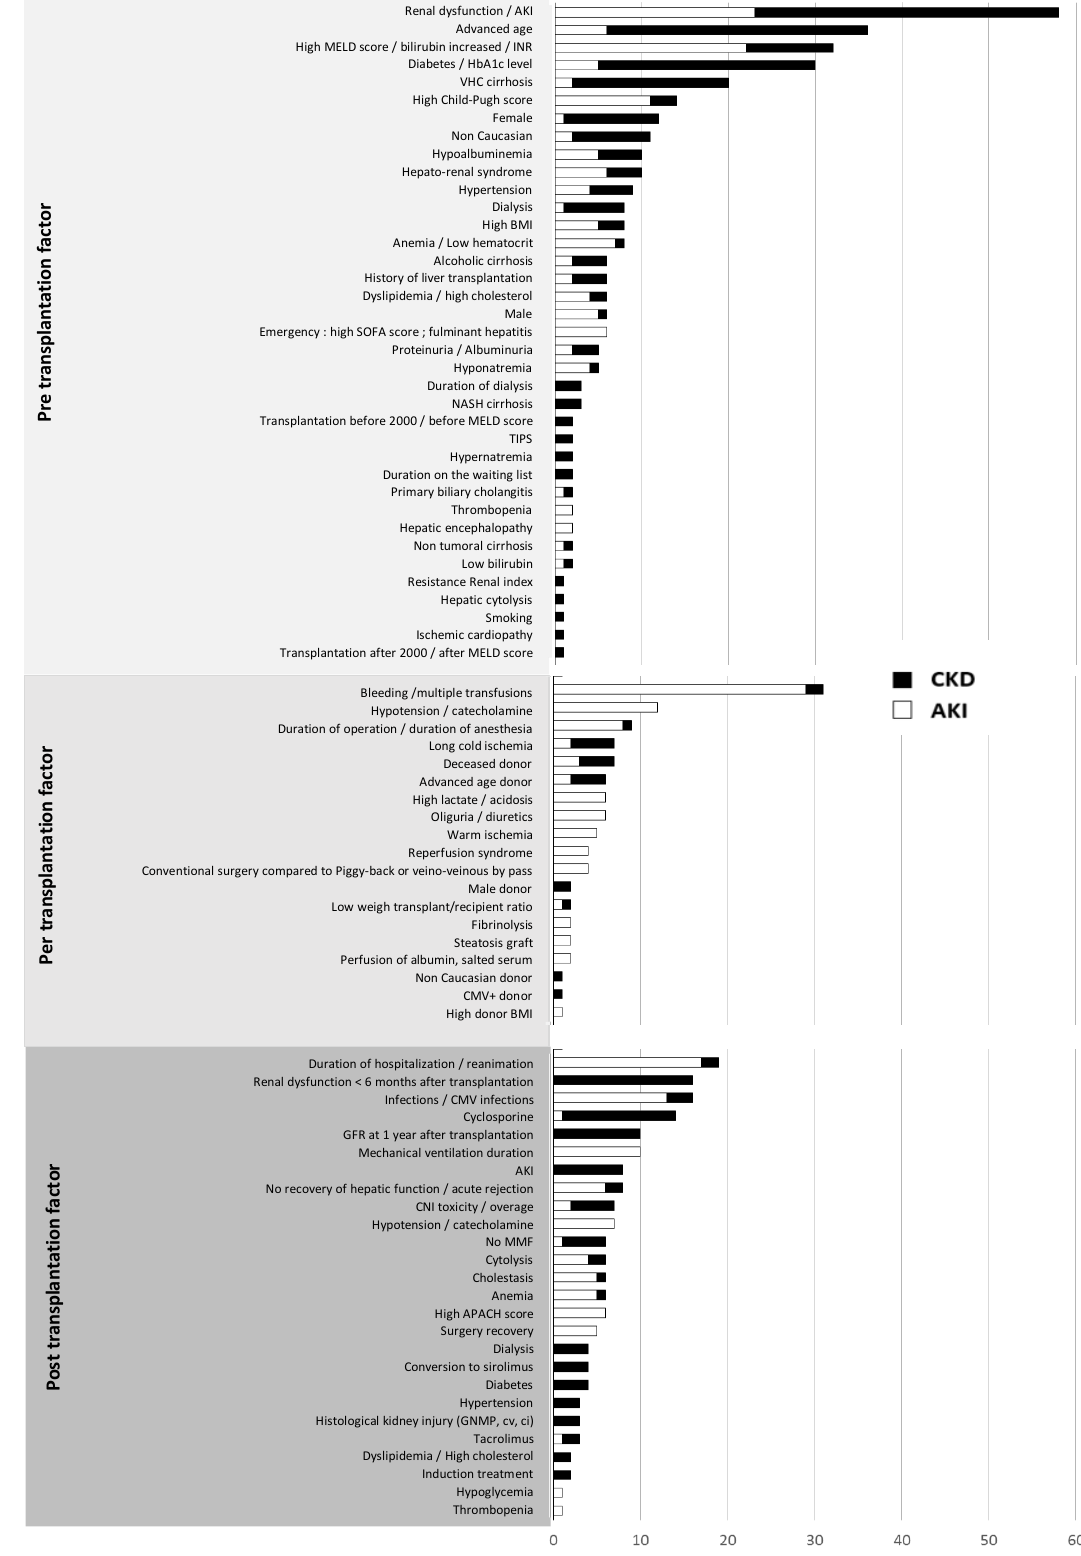
Figure 1. Inventory of the pre-transplantation, perioperative and post-operative risk factors for AKI or CKD according to the number of studies that mention them [8,10,14 – 34,36 – 38,40 – 46,48,53,56,60 – 64,70,71,73,76 – 87,89 – 97,104,106 – 108,111 – 113,115 – 136]. AKI: acute kidney injury; CKD: chronic kidney disease.